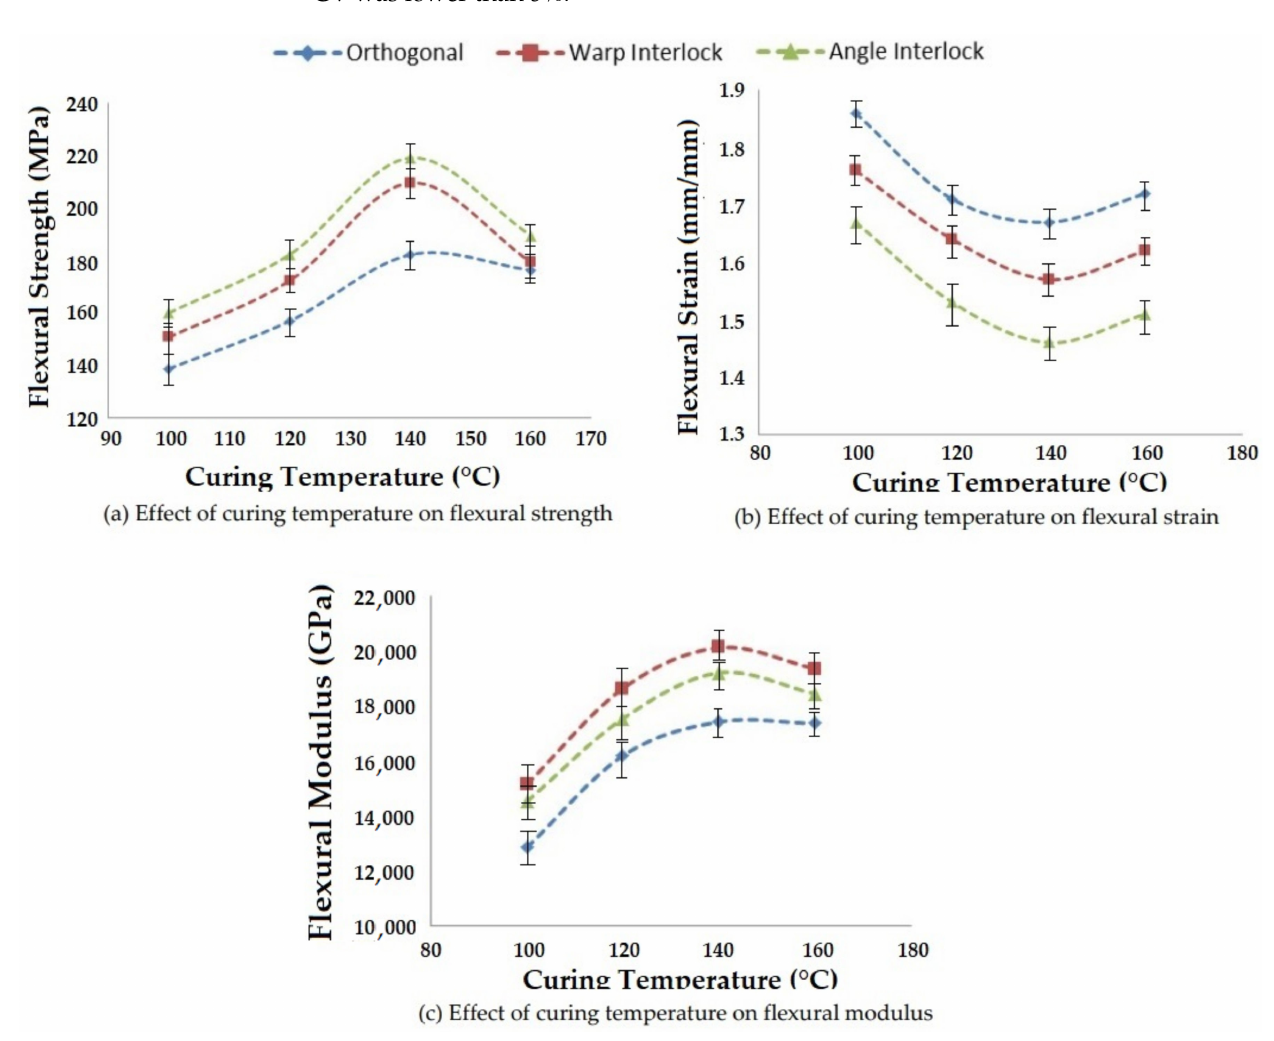
Figure 20. Effect of curing temperature on the flexural properties of 3D woven